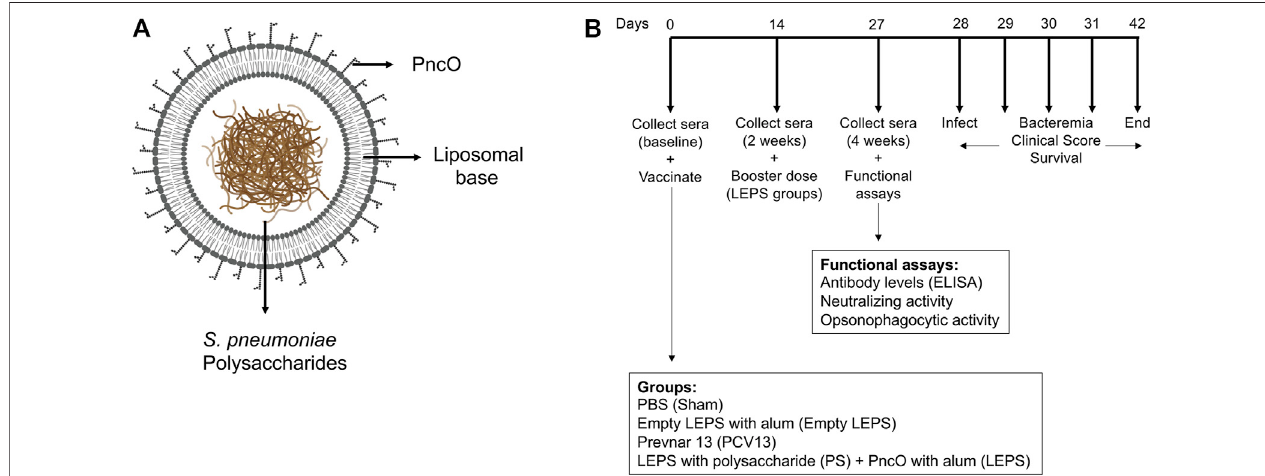
FIGURE 1 | Vaccine design and experimental set-up. (A) LEPS design. The LEPS vaccine consists of the liposomal carrier encapsulating bacterial polysaccharide with PncO linked to the surface. (B) Vaccination timeline. Mice were mock treated with 50 μ l PBS (Sham), empty LEPS with alum (Empty LEPS), or administered either thepneumococcalconjugatevaccinePrevnar13(PCV13)ortheLEPSvaccinecontainingbacterialpolysaccharideinadditiontoPncOandalum(LEPS)viaintramuscular ( i.m ) injections to the hind legs. Two weeks following the initial vaccination, the LEPS and Empty LEPS groups received a booster dose. Sera were collected at baselineandtwoand4 weekswithrespecttotheinitialvaccination toassessantibodylevelsandfunction.Fourweeksfollowingvaccinationmicewerechallenged intra- tracheally ( i.t. ) with S. pneumoniae and monitored for bacterial burden and clinical signs of disease.